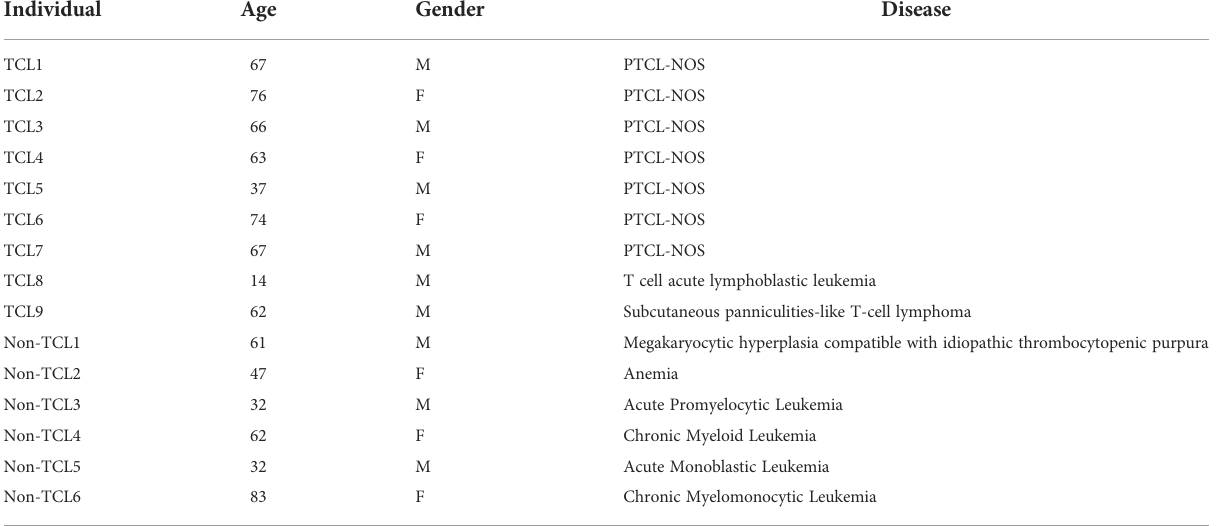
TABLE 1 Characteristics of TCL and non-TCL patients for digital